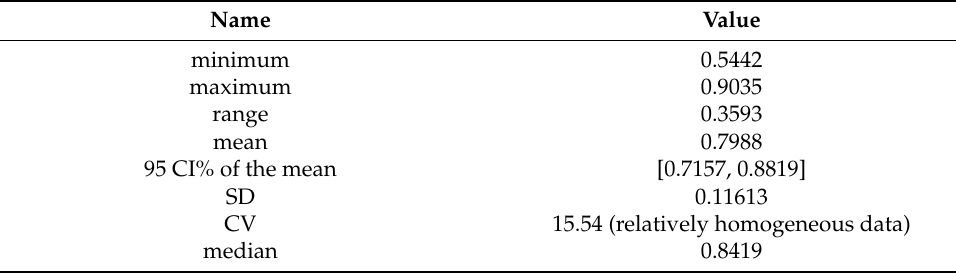
Table 7. Descriptive statistics for precision (data from Table